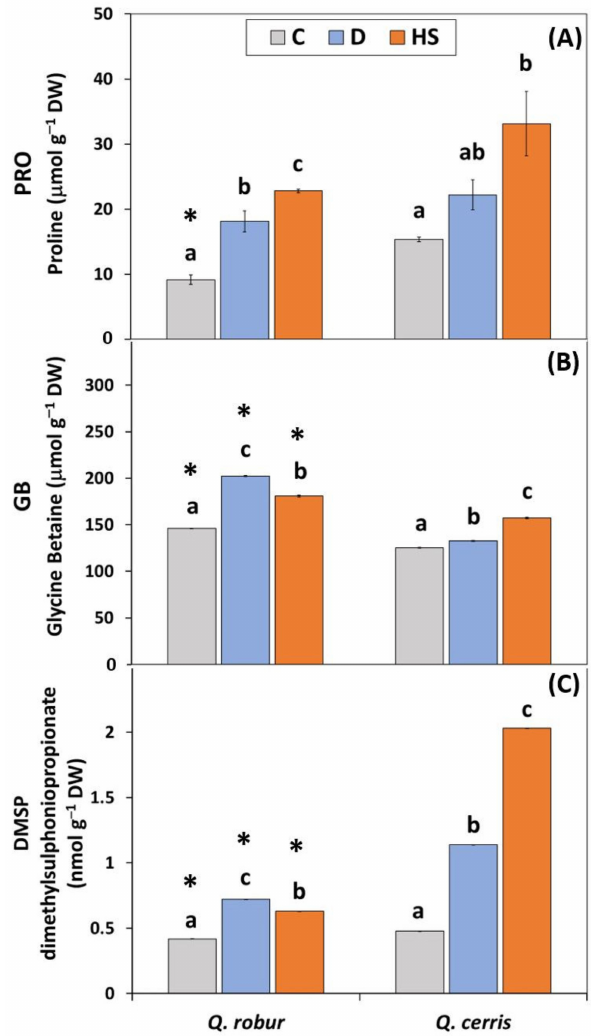
Figure 1. Changes in: ( A ) proline (PRO; µ mol g − 1 DW); ( B ) glycine betaine (GB; µ mol g − 1 DW); and ( C ) dimethylsulphoniopropionate (DMSP; nmol g − 1 DW) content in leaves of Quercus robur and